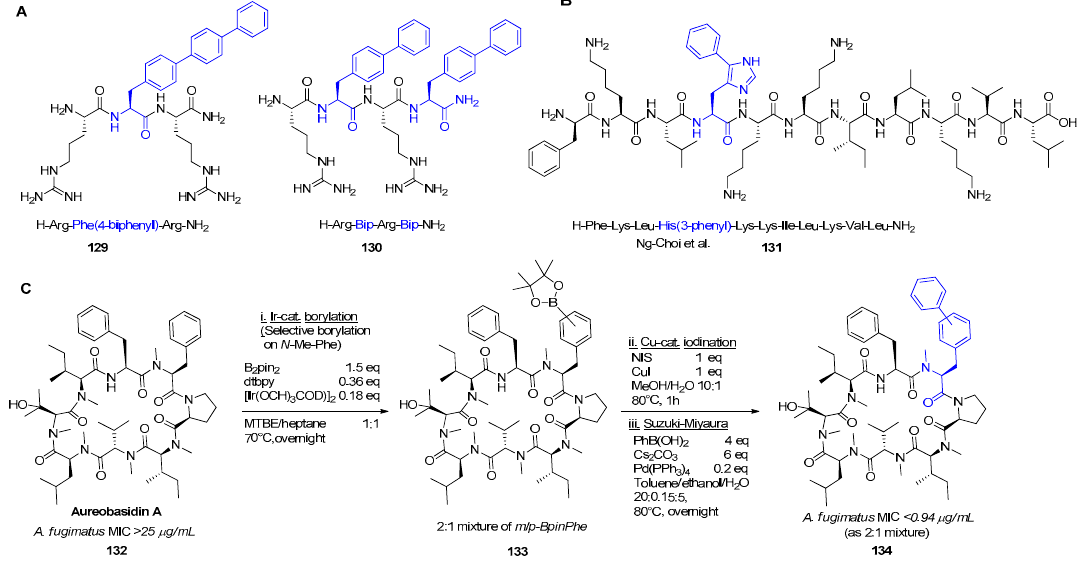
Figure 19. ( A ) Short cationic antimicrobial peptides 129 and 130 featuring, respectively, triaryl-and biarylphenylalanine ( B ) Improvement of the antimicrobial activity of undecapeptides by incorporation of 5-arylhistidine ( C ) Improvement of antifungal activity via borylation-Suzuki–Miyaura reaction on Aurebasidin A 134 .